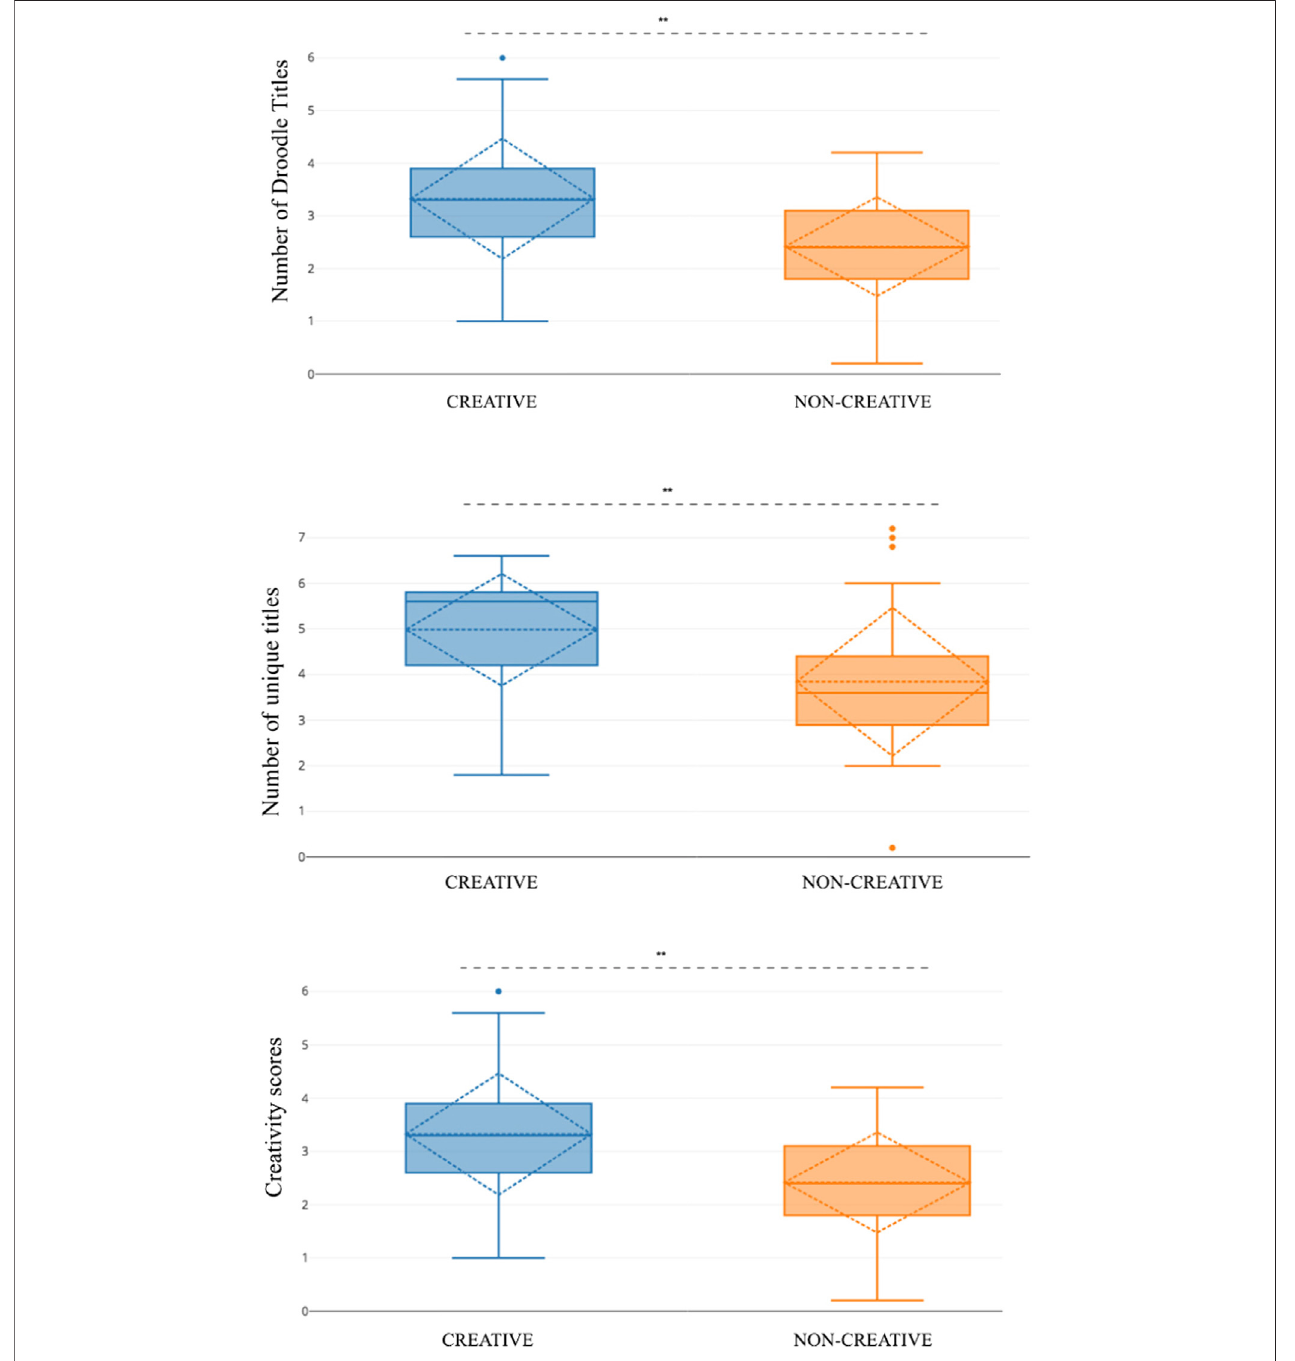
FIGURE 6 | Participants in the C+ condition group generated signi fi cantly more Droodle titles, more unique titles and highly creative titles as compared to the C − group.